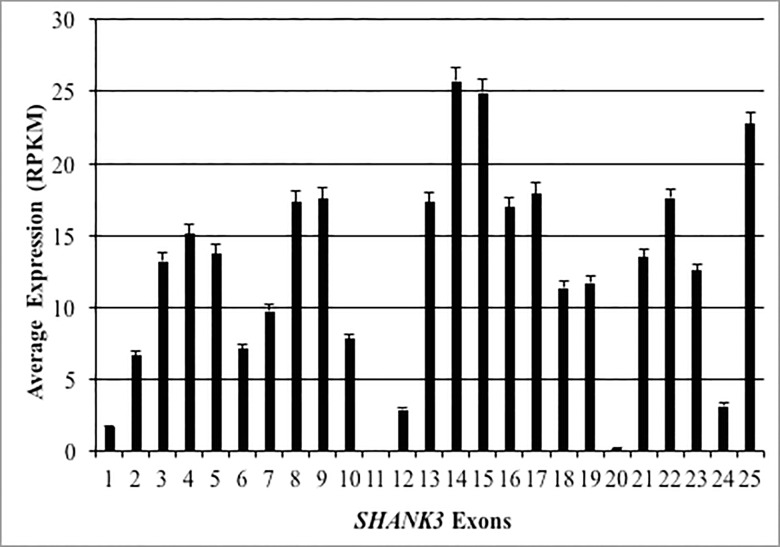
Average expression of SHANK3 exons.The average expression of each individual SHANK3 exon across all brain regions and developmental time periods is shown. Error bars represent the standard error of the mean.